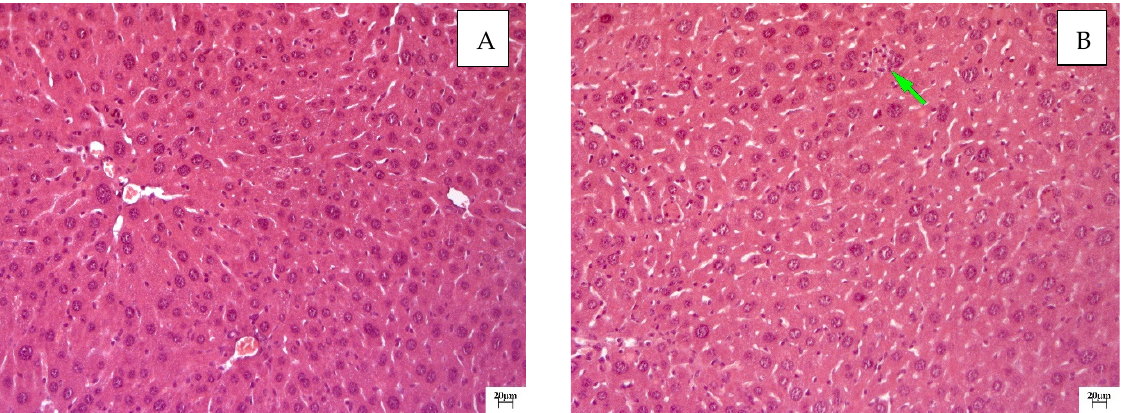
Figure 3. Histological examination of a mouse liver treated with QS-528 at doses of 60 and 90 mg/kg for 3 weeks: ( A ) Mice treated with QS-528 at a dose of 60 mg/kg. Severe hepatocyte hypertrophy and nuclear hyperplasia. Staining with hematoxylin–eosin, ×200. ( B ) Mice treated with QS-528 at a dose of 90 mg/kg. Cell necrosis with infiltration by lymphocytes and macrophages. Green arrow indicates necrosis of hepatocytes. Staining with hematoxylin–eosin, ×200. QS-528 at doses of 120 and 150 mg/kg, in contrast to animals treated with this sub- stance at doses of 60 and 90 mg/kg, had a positive effect on reparative processes in the liver. The heterogeneity of hepatocytes was manifested in the form of a slight disturbance of the nuclei. Small vesicular lipid degeneration was recorded in individual animals and was focal in nature (Figure 4A,B). Large cells (macrophages) were observed periportally. Kupffer cells and lymphocytes were detected in the sinusoids. Reparative regeneration in this case was realized by the mechanism of compensatory hyperplasia, which is typical of